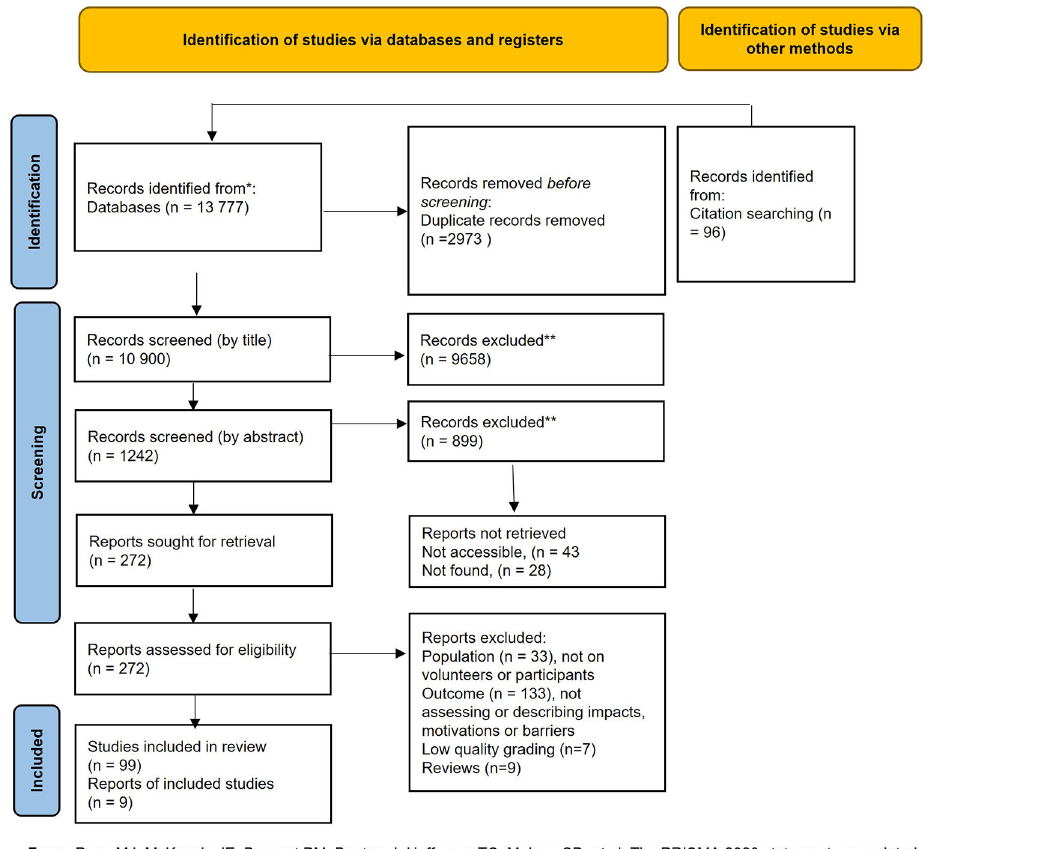
Figure 2. Prisma-P diagram for the literature search and appraisal